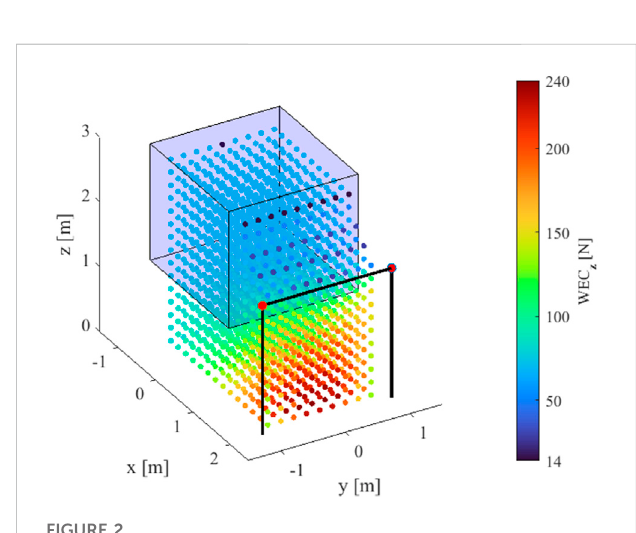
FIGURE 2 Results of a WEC z -based workspace